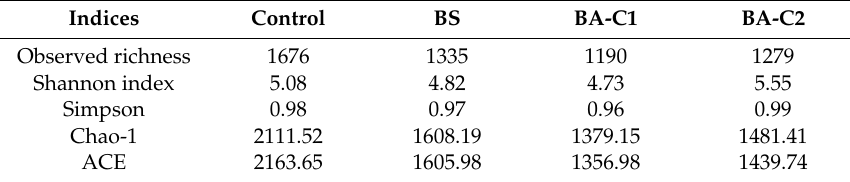
Table 5. Richness and diversity of bacterial communities in the analyzed soil samples.